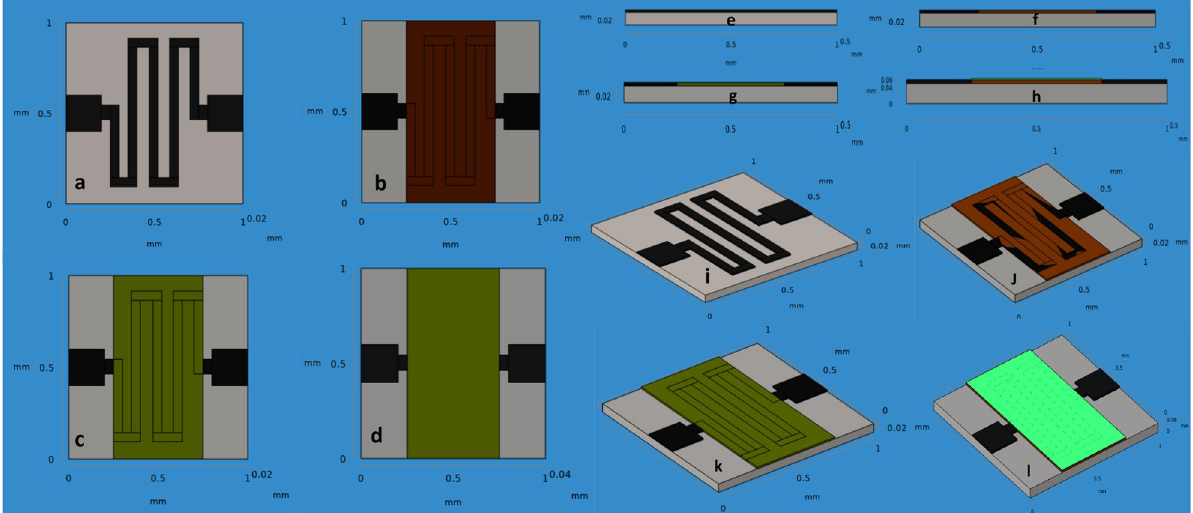
Figure 3. Design of chemical gas sensors ( a ) Sn thin film with Au contact ( b ) Sn–Pd with Au contact ( c ) Sn– rGO with Au contact ( d ) Sn–Pd–rGO with Au contact ( e – h ) Cross sectional view of all four sensors and ( i – l ) Diagonal view with layers of all four sensors.